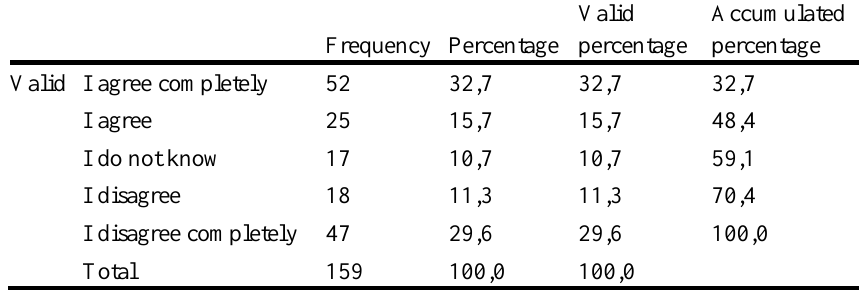
Valid percentage questionnaires´ results, question 12 “Learners would like to have more subjects within the bilingual